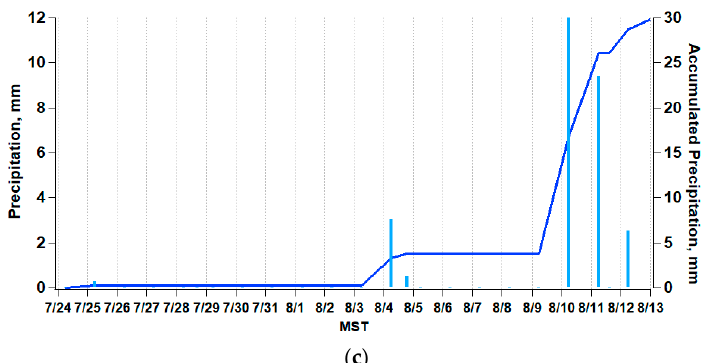
Figure 3. Meteorological conditions observed during the campaign period from 24 July to 12 of August 2018. Ensembled averages of ( a ) RH and ( b ) T. ( c ) Time series of daily precipitation amounts and accumulation in mm from NTN.